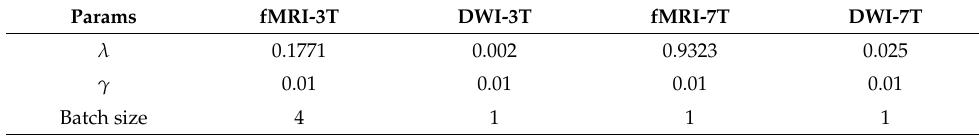
Table 3. Values of hyper-parameters in training TS-Net on the four